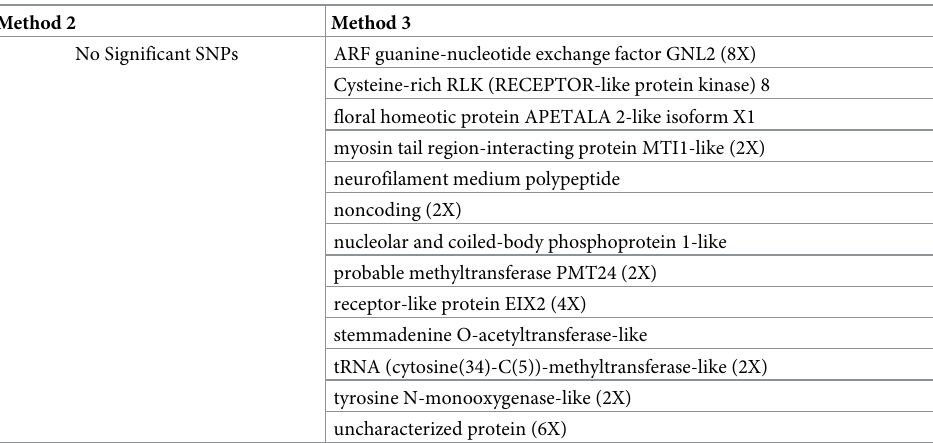
Table 3. Genes with significant associations for non-chemical traits.